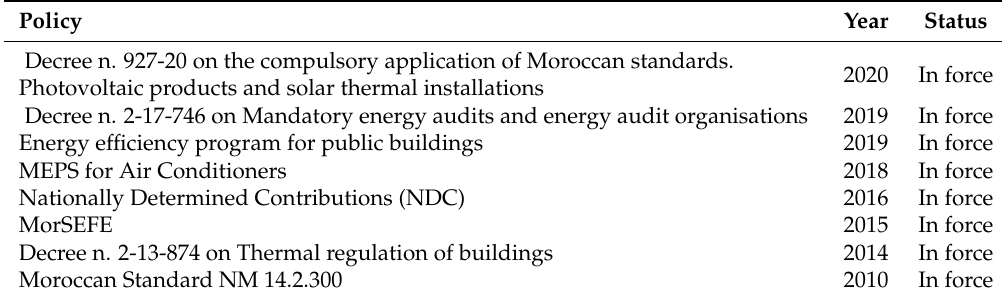
Table 1. Energy regulations in the building sector